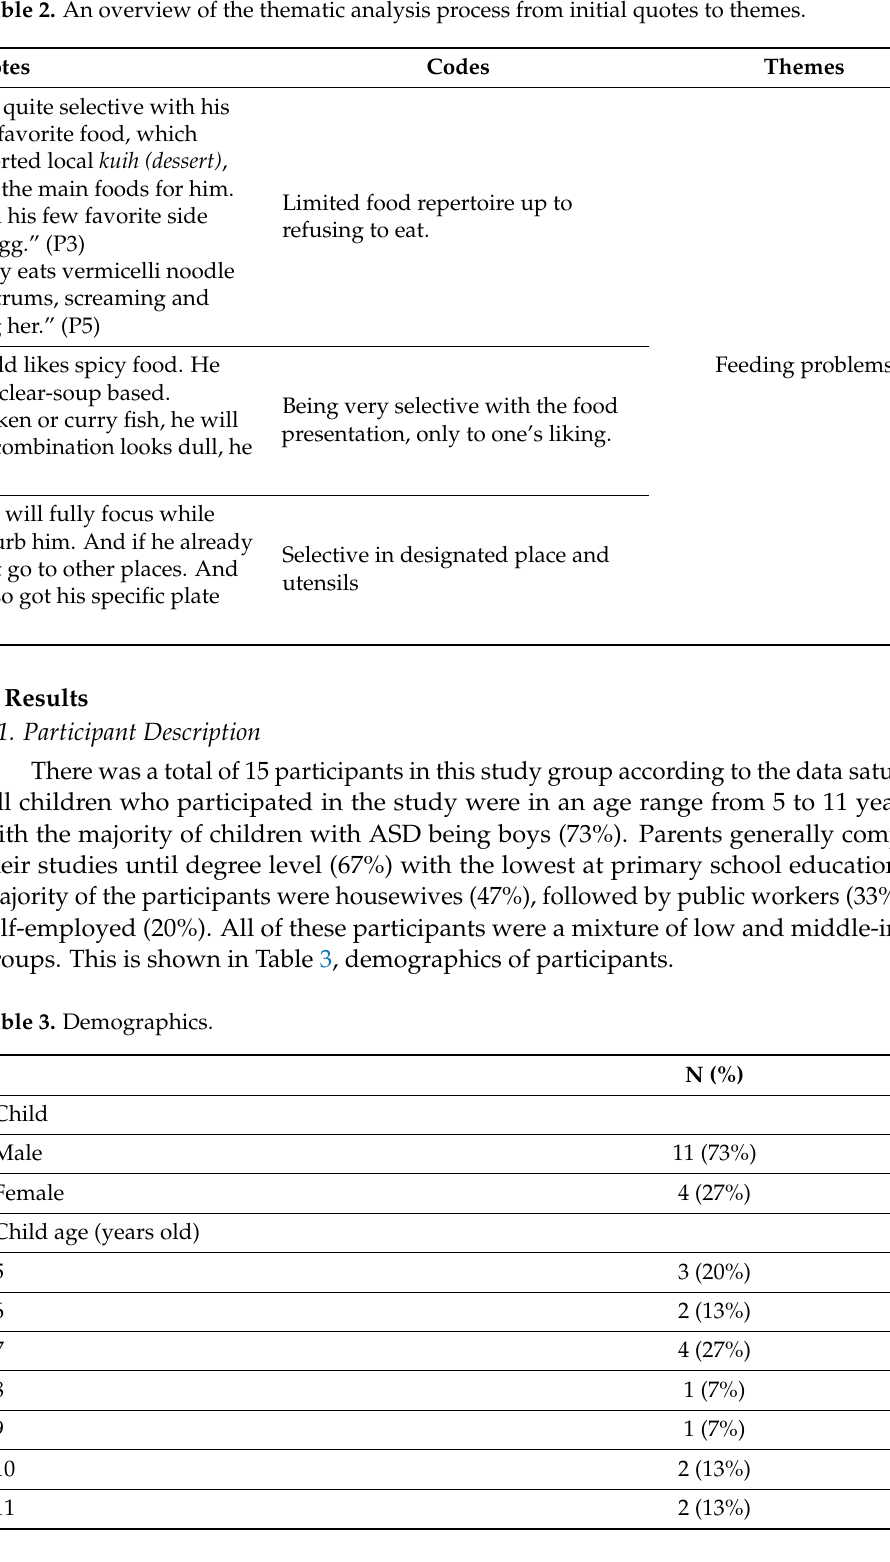
Table 2. An overview of the thematic analysis process from initial quotes to